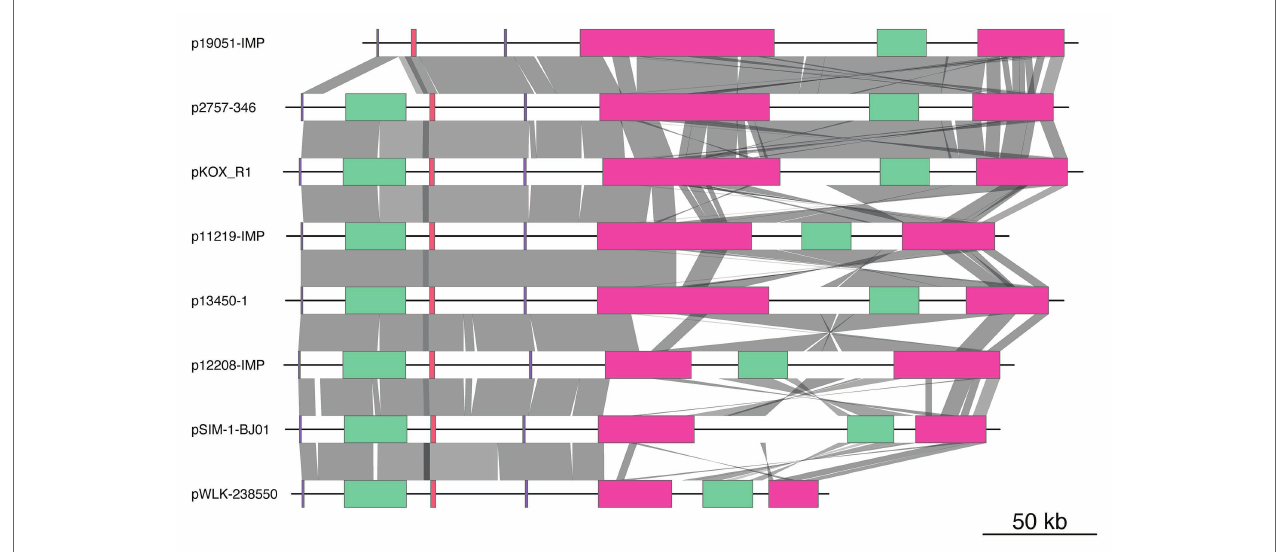
FIGURE 2 | Comparison of the genome structure of eight plasmids. The color-coded boxes indicate different gene functions, including replication (in purple), plasmid transfer (in green), plasmid partition (in pink), and antibiotic resistance island (ARI; in red). Orthologous regions are connected and color coded. The